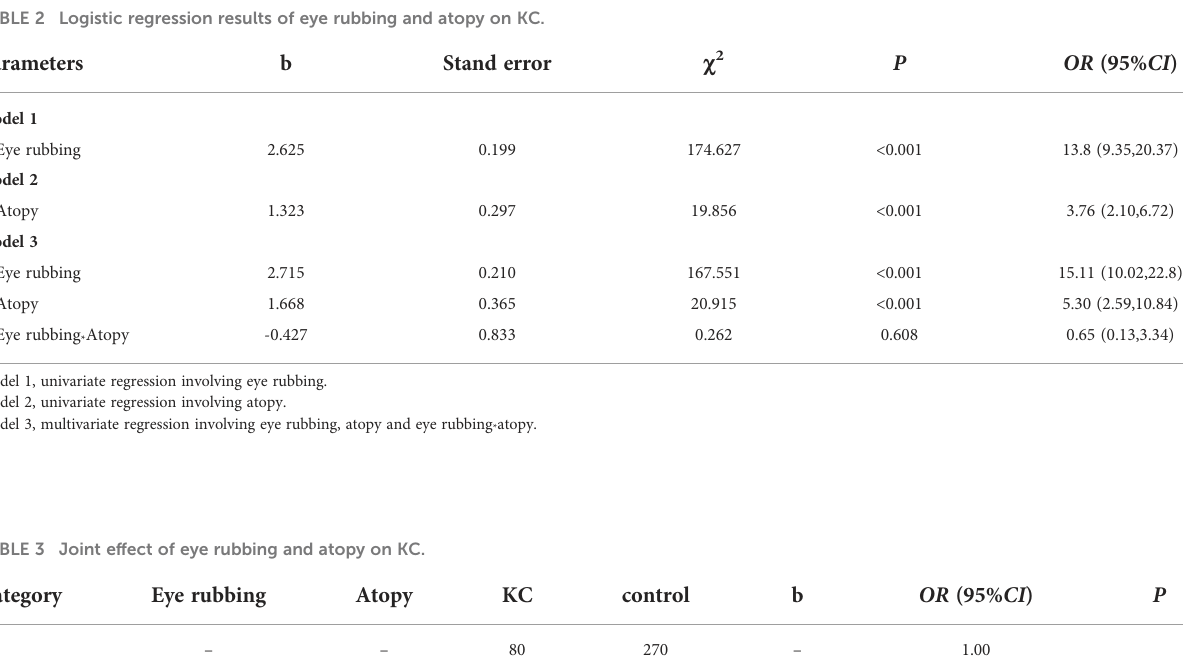
TABLE 2 Logistic regression results of eye rubbing and atopy on KC.